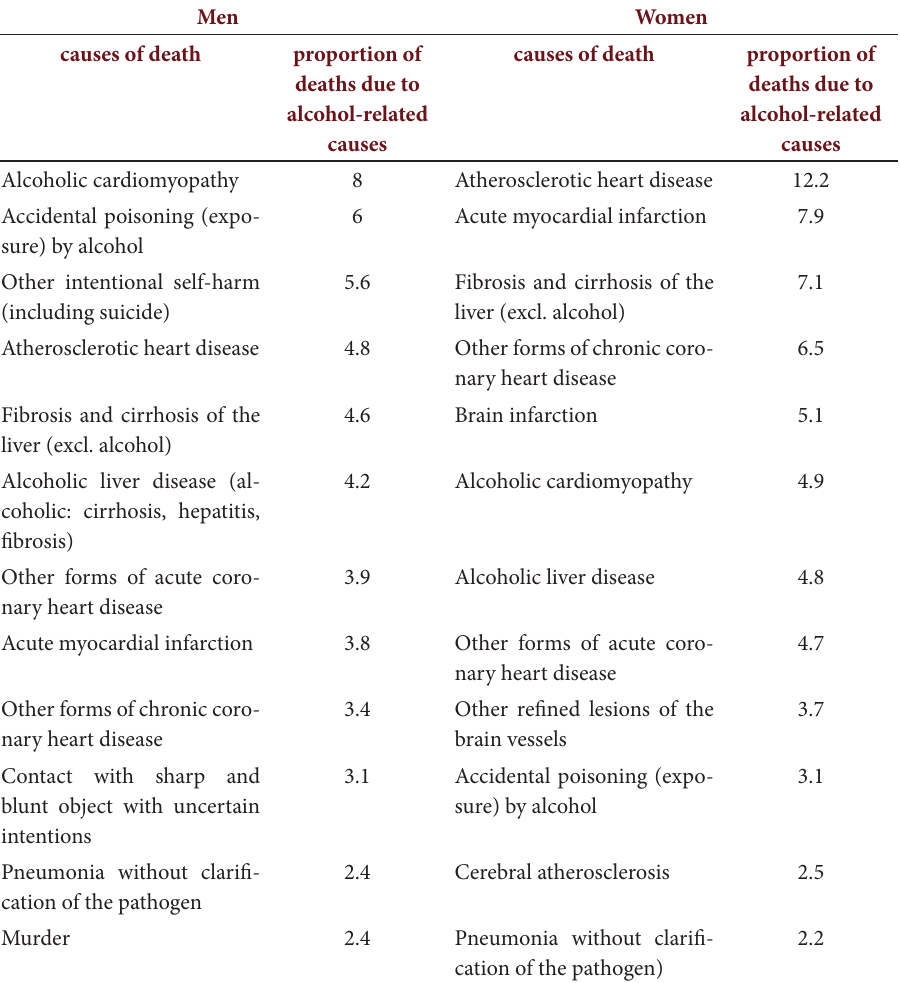
Table 3. Number of deaths due to excessive alcohol consumption, depending on cause of death (ICD- 10 classification), alcohol mortality rate (%), men and women, 2018 Men Women causes of death proportion of causes of deaths due to causes